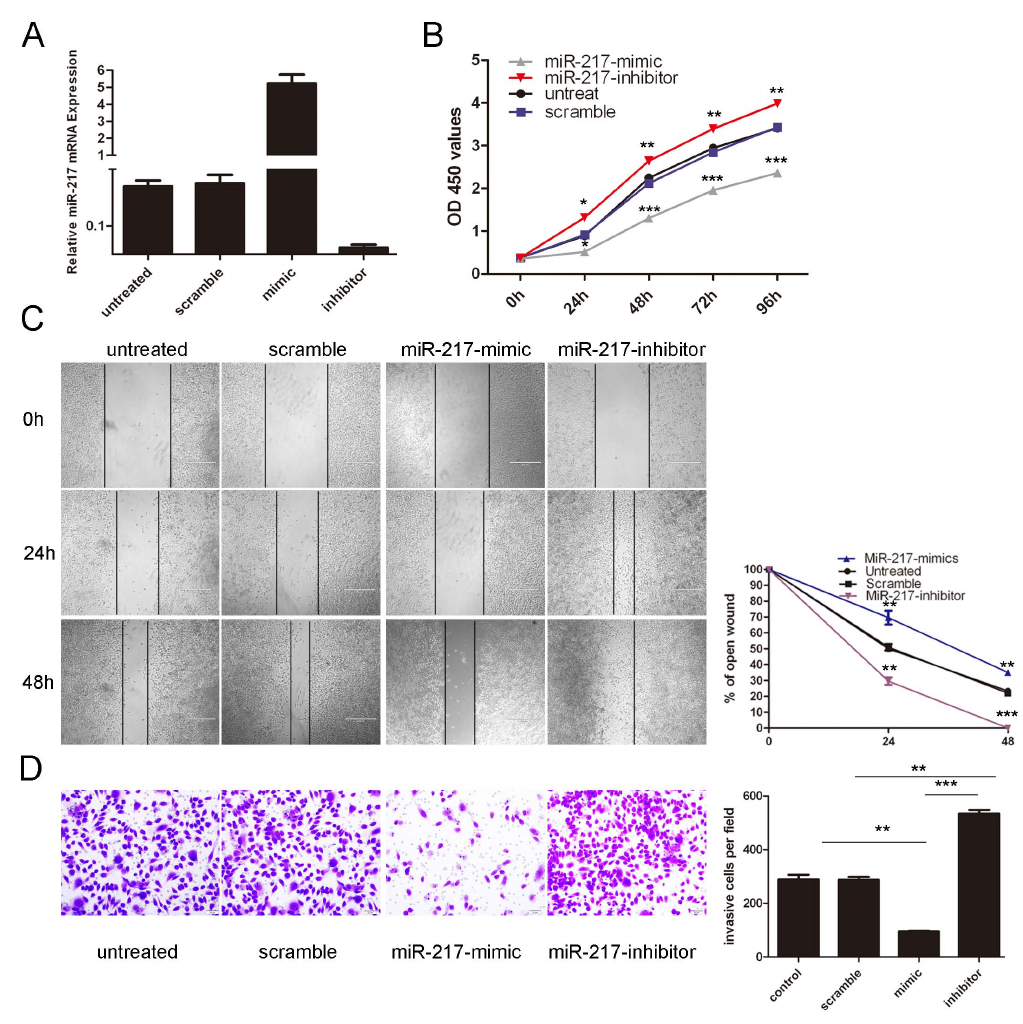
Figure 2. Overexpression of miR-217 inhibits the osteosarcoma cell line MG-63 proliferation, migration, and invasion. (A) Expression levels of miR-217 were examined by qRT-PCR after transfection of 20 nmol/L of miR-217 mimics, inhibitors or sramble or no transfection in the cell line MG-63. (B) The cells treated with miR-217 mimics, inhibitors or sramble or no transfection were measured by CCK8 assay at different time periods. (C) Wound healing assays of MG-63cells after treatment with miRNA mimics, inhibitors or scramble or no transfection; the relative ratio of wound closure per field is shown. (D) Transwell analysis of MG-63 cells after treatment withmiRNA mimics, inhibitors or scramble or no transfection; the invasive cells per field is shown below, All data uses t test and is shown as mean 6 SEM. *p , 0.05,** p , 0.01, and ***p , 0.001.